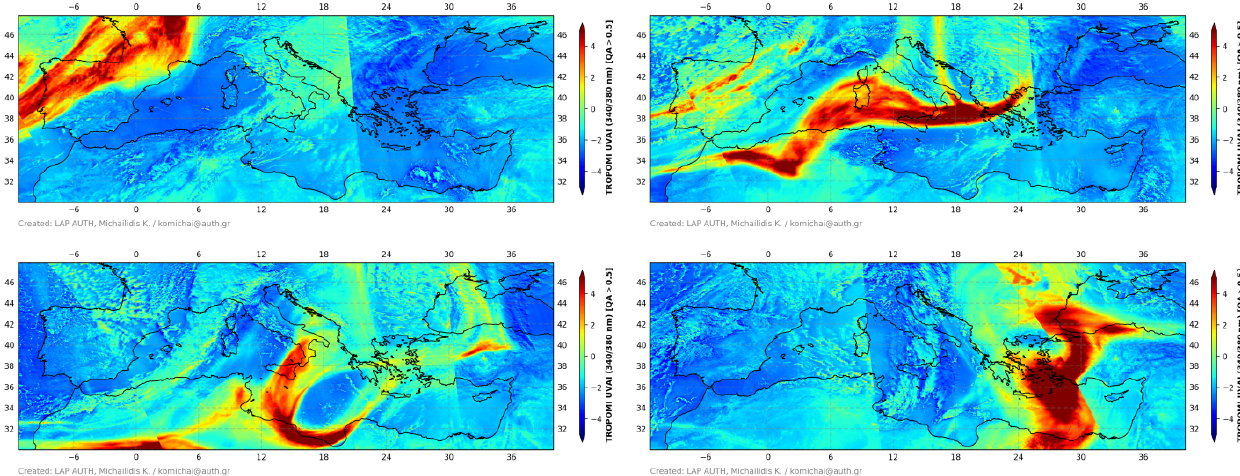
Figure 7. TROPOMI UV aerosol index (UVAI) retrievals during the smoke plume transport over the Mediterranean during 24–27 Octo- ber